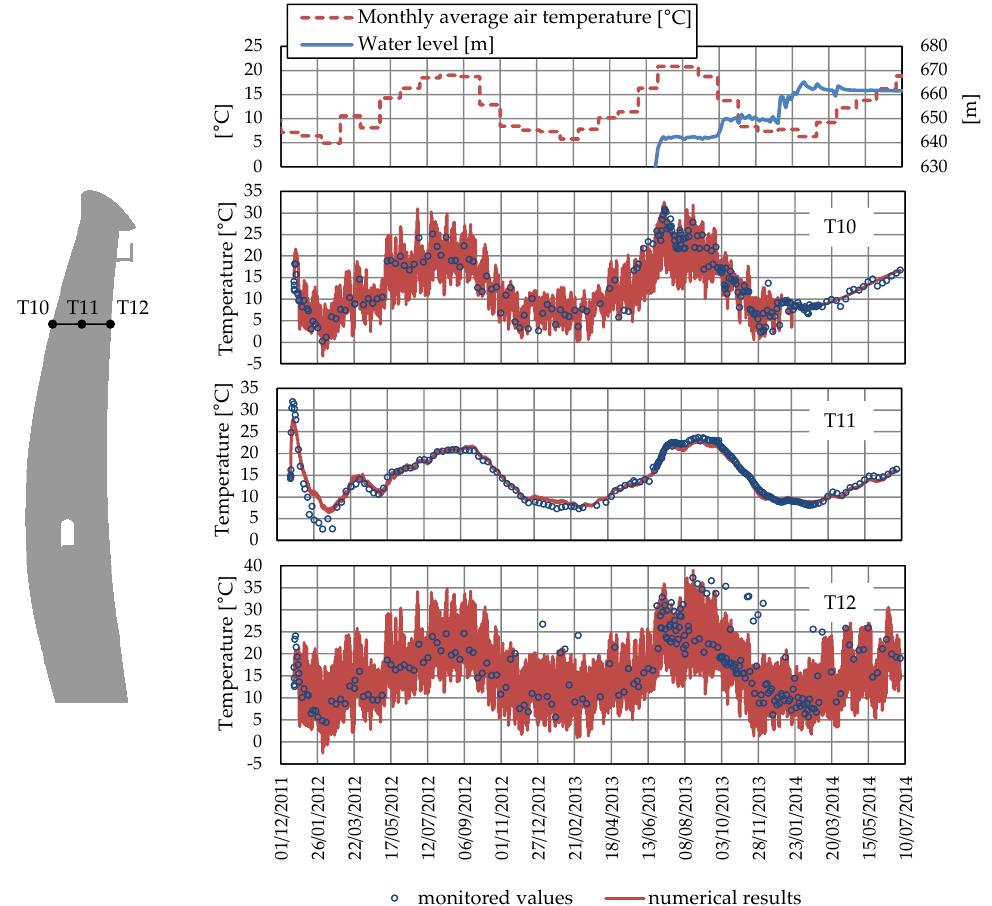
Figure 9. Monthly average air temperature, reservoir levels, and comparison of predicted and monitored temperatures at thermometers T10 to T12.